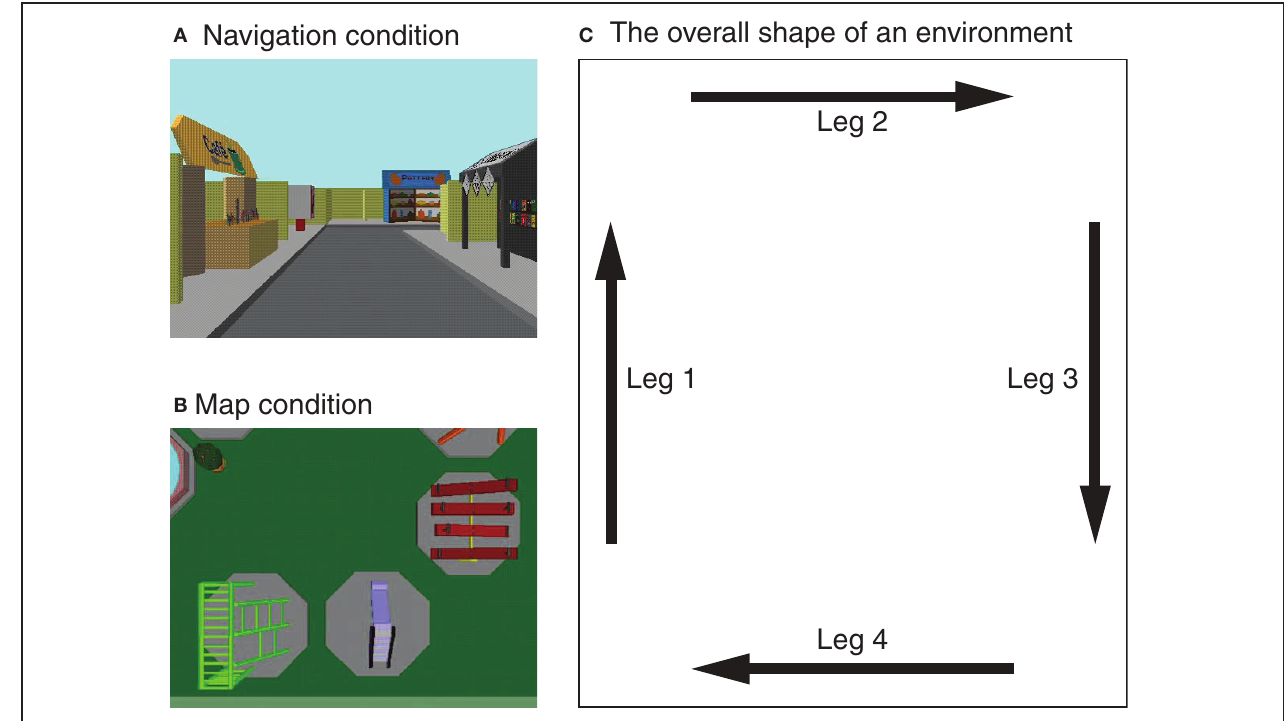
(lower left corner in the figure) and proceeded clockwise along the four legs (C) . These virtual environments were originally created and used by Shelton and colleagues (Shelton and Gabrieli, 2002; Shelton and McNamara,